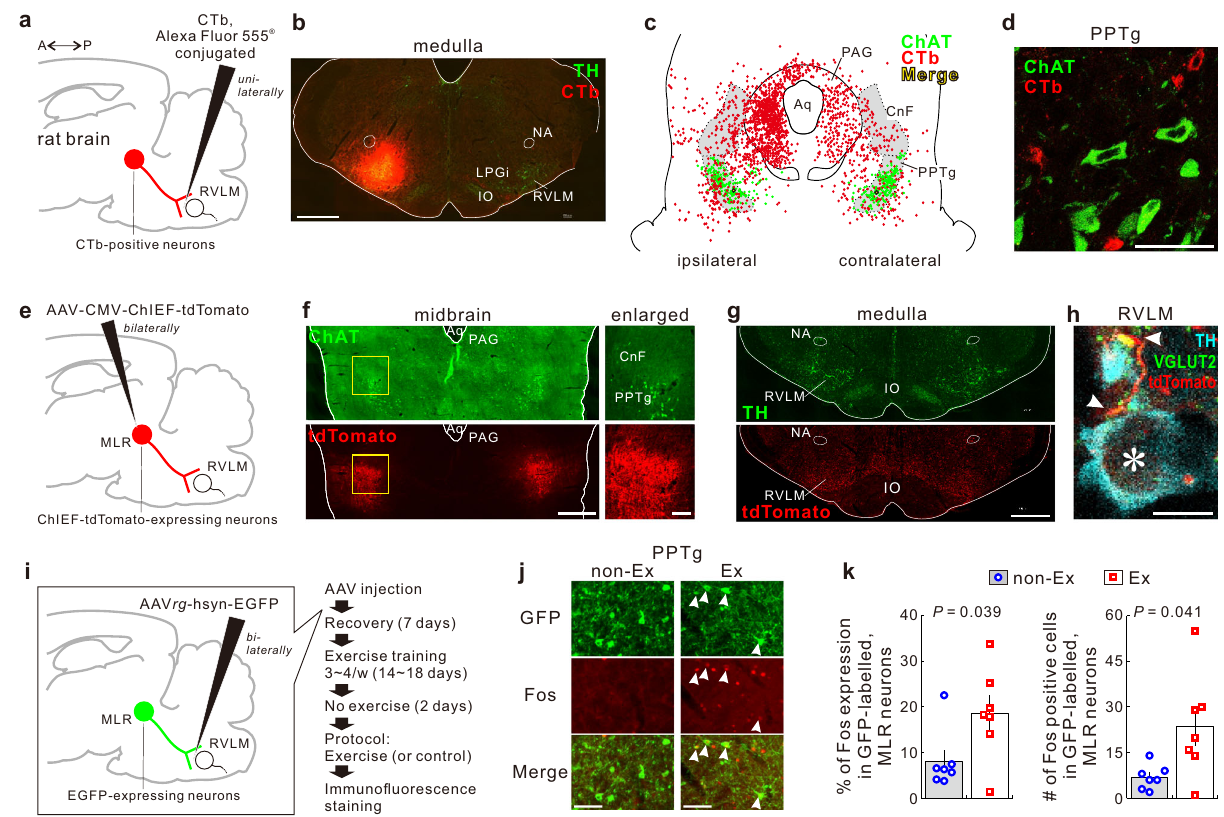
Fig. 1 | MLR neurons projecting to the RVLM mediates central command sig- naling. a , b CTb injection into the RVLM unilaterally. TH tyrosine hydroxylase; IO inferior olive nucleus; LPGi lateral paragigantocellular nucleus; NA nucleus anbi- guus.Scalebar:1mm. c DrawingofthedistributionofCTb-labeledcells[combined from 8 rats (6 males, 2 females)] and CTb-positive or -negative ChAT- immunoreactive cells [combined from 3 of 8 rats (2 males and 1 female)] in the midbrain coronal section. Aq aqueduct; PAG periaqueductal gray. d Confocal image showing that CTb-labeled PPTg cells were not merged with ChAT- immunoreactive cells. Scale bar: 50 μ m. e , f AAV-CMV-ChIEF-tdTomato injections into the MLR bilaterally. Scale bars: 1mm (midbrain) and 200 μ m (enlarged). g tdTomato-labeled axons distributed in the ventral medulla. Scale bar: 1mm. h ConfocalimageshowingcloseassociationsoftdTomato-labeledaxonalswellings containing VGLUT2 (arrowheads) with RVLM C1 neuronal dendrite and cell body